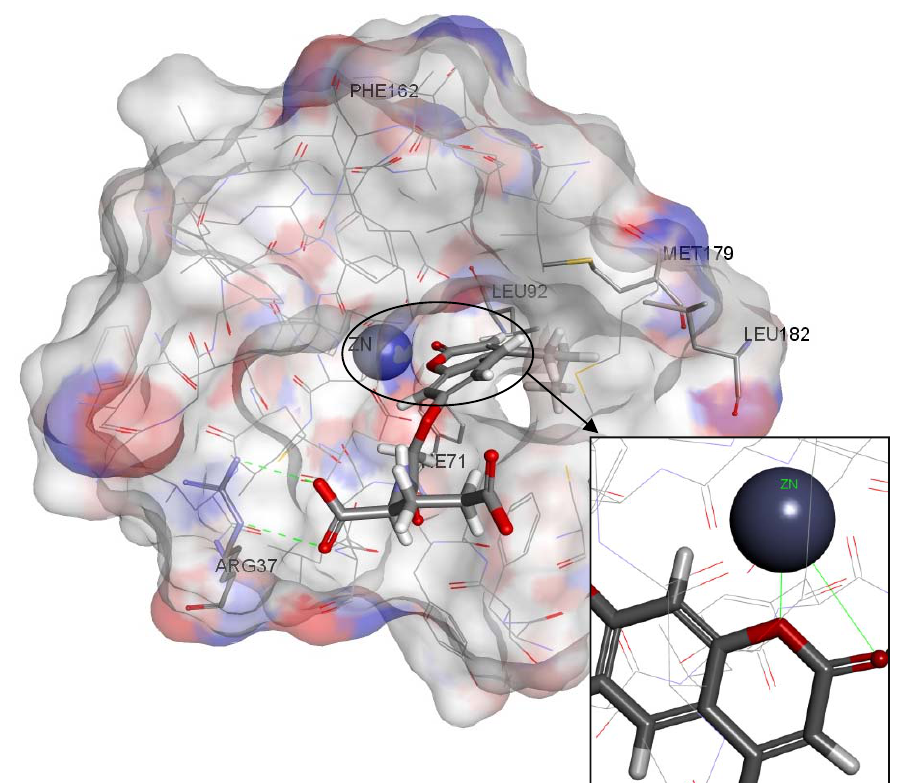
Figure 9. Zinc02120846 docked inside the Glo-1 active site.